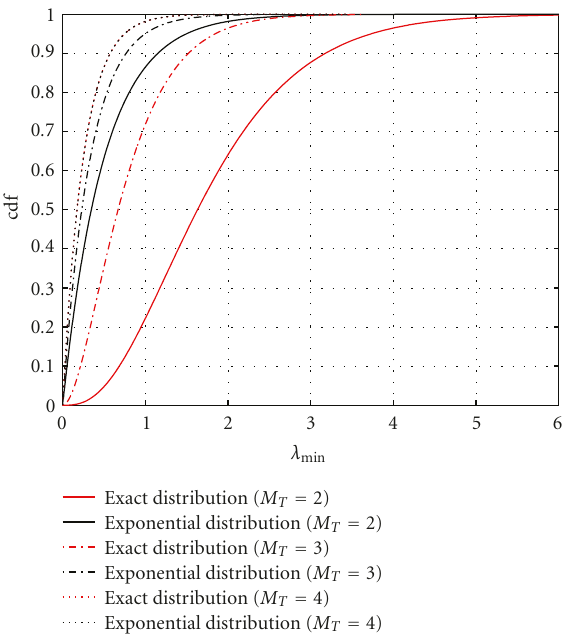
Figure 1: The cdf of the smallest eigenvalue of (cid:4) H (cid:4) H H and corresponding exponential distribution approximation ( M R = 4, = 15dB). N P = 4, P d /σ 2 n